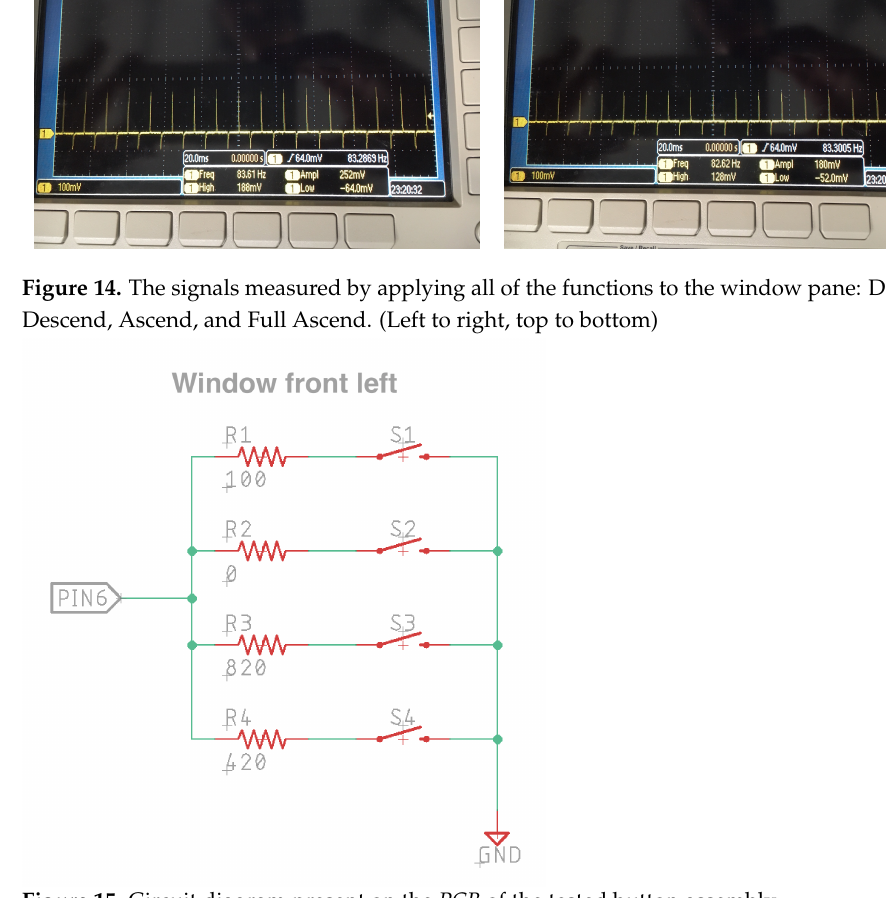
Figure 15. Circuit diagram present on the PCB of the tested button